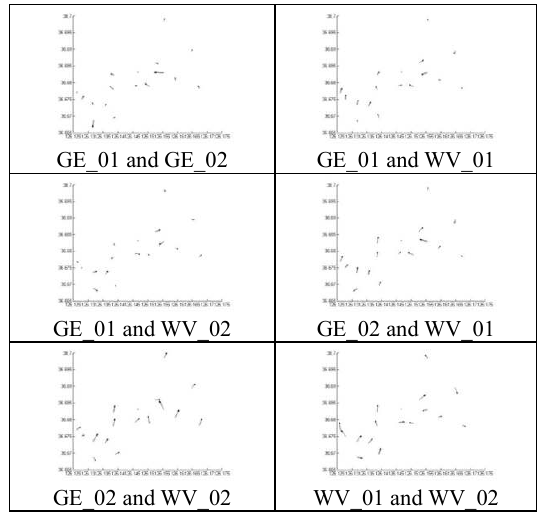
Figure 5. Residuals of stereo models with single GCP